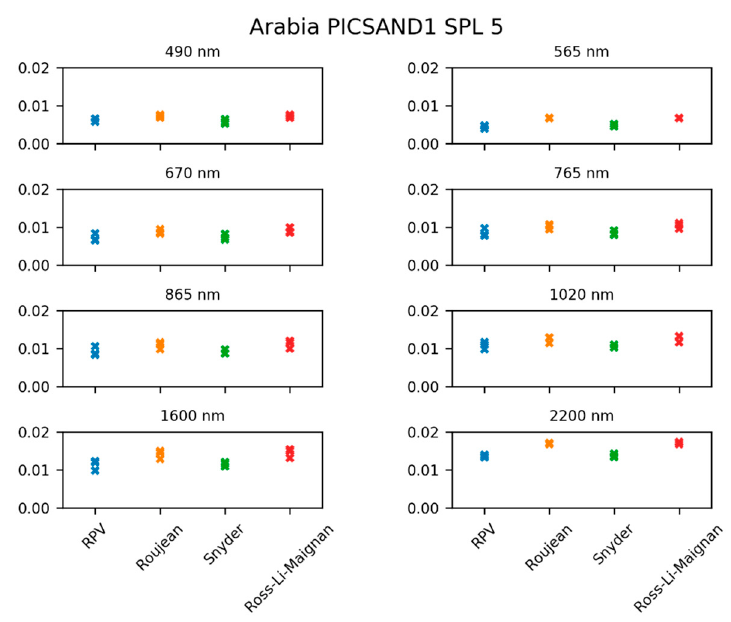
Figure 16. Arabia_PICSAND1 _SPL1 residual RMSD between the measured BCRF in the six POLDER wavelengths plus two wavelengths in the SWIR (1600 and 2200 nm) for the three rotating positions, and the four fitted BRDF models.